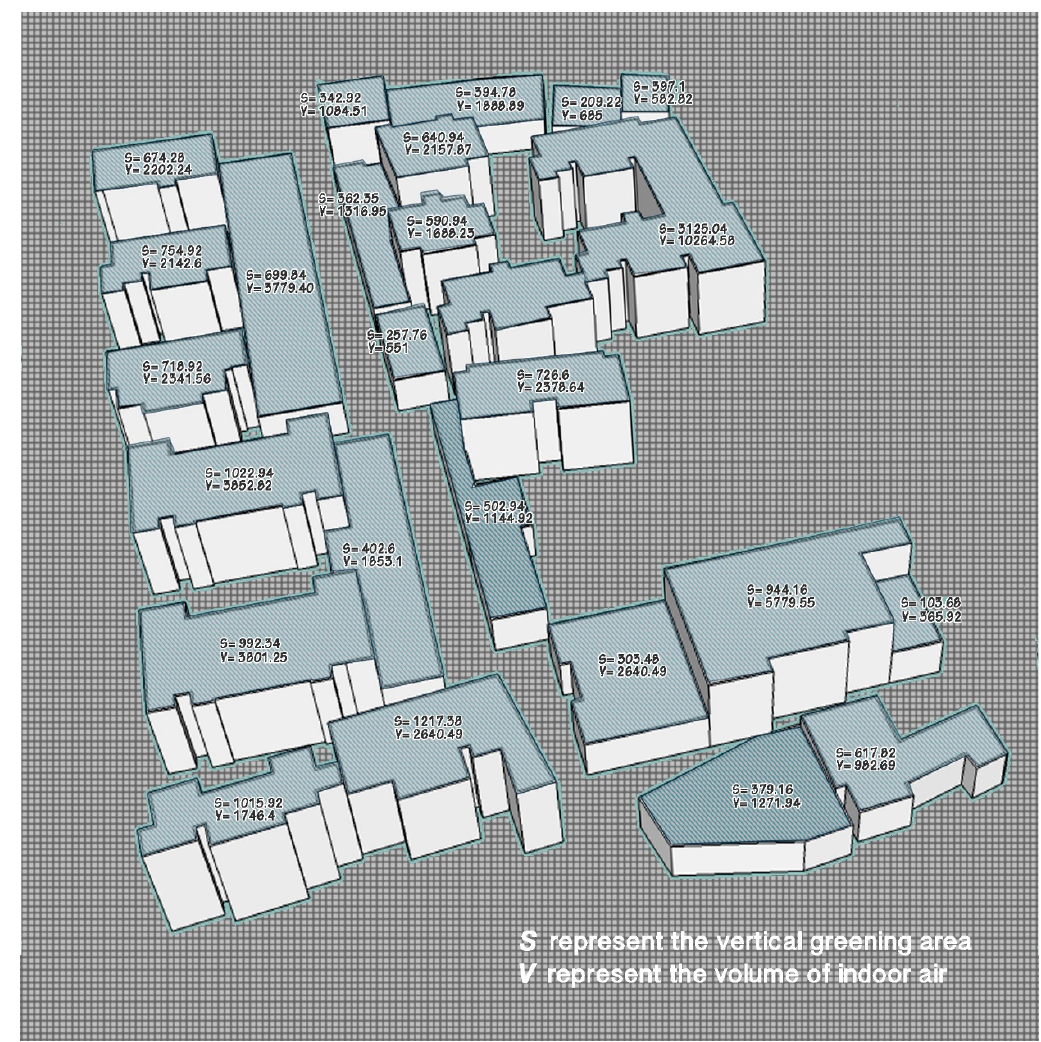
Figure 14. Building cavity volume and green wall area.